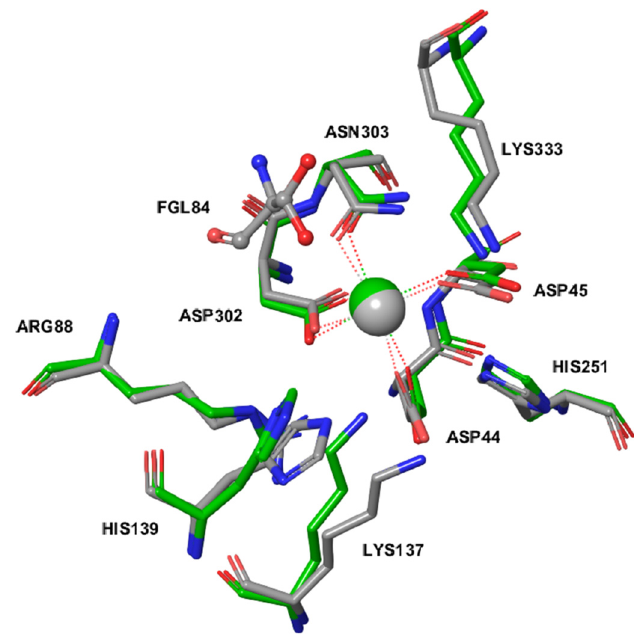
Figure 4. Superposition of catalytically important amino acids in the ARSG homology model (gray) and in ARSB (PDB ID: 1FSU) (green). The formylglycine (fGly)-diol of ARSG is shown in a ball-and-stick representation. Marked in red are oxygen atoms, marked in blue are nitrogen atoms.